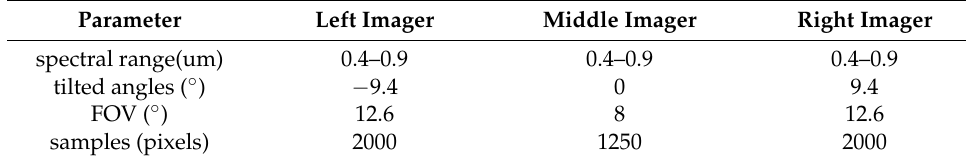
Table 1. Main features of AWSHRHIS.